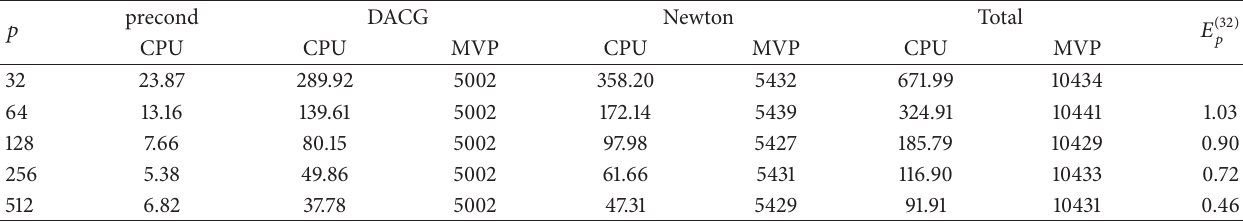
Table 9: Iterations, timings, and pseudo efficiencies for problem GEO-1438